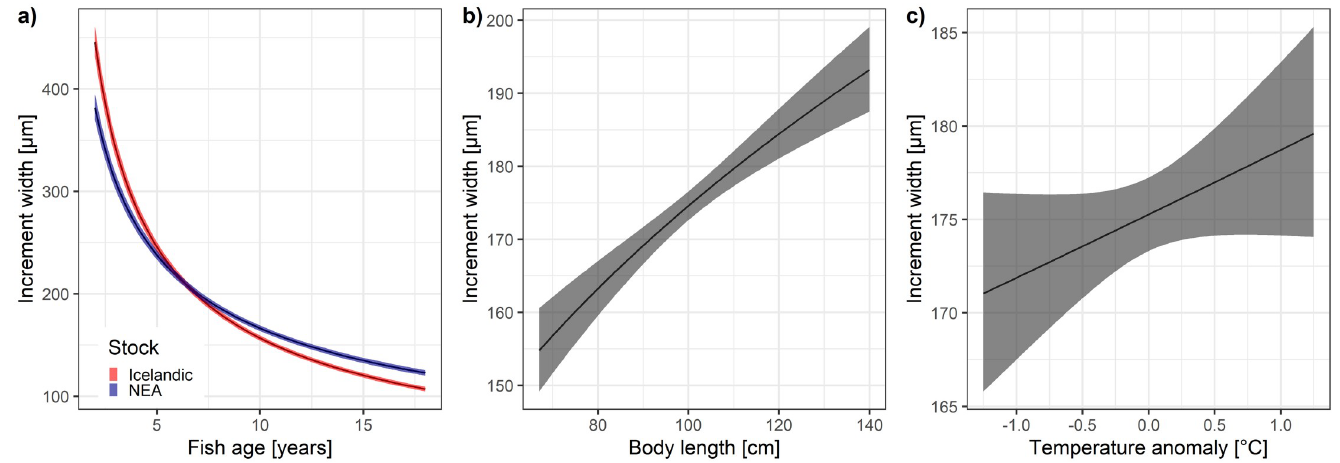
Fig 4. Effects of the variables predicted by the univariate model of otolith increment width selected based on the AICc.